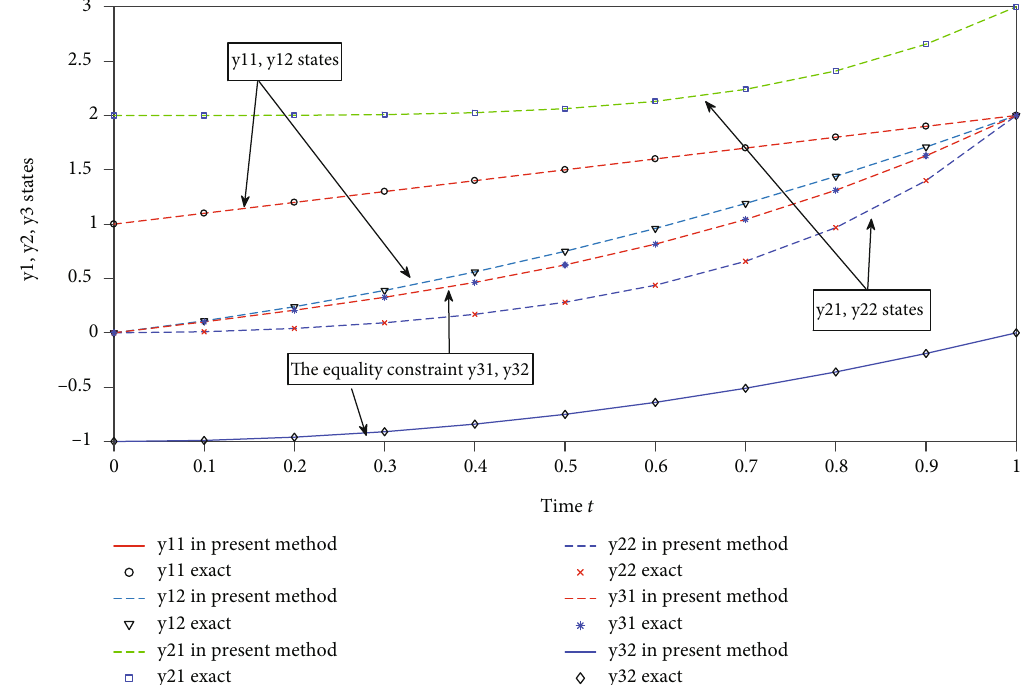
Figure 1: Comparisons between the proposed approach and the exact